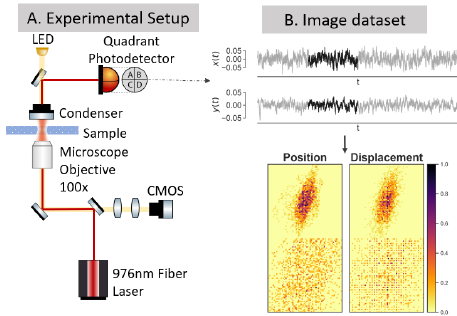
Figure 1. On the left, scheme of OT setup with quadrant pho- todetector for particle tracking and on the right image plotting procedure.